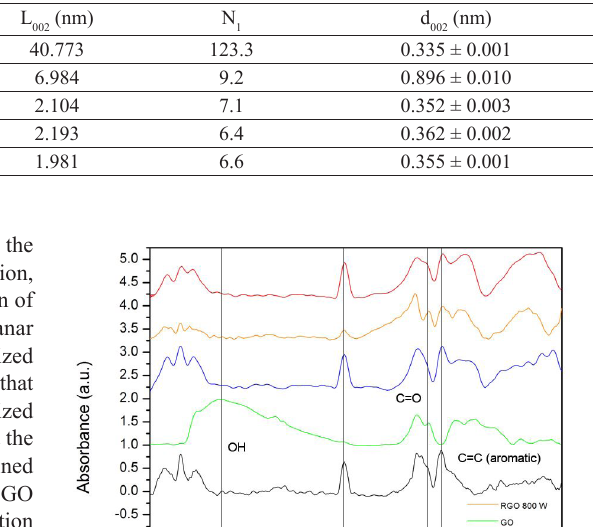
Table 2. Interlayer distance (d